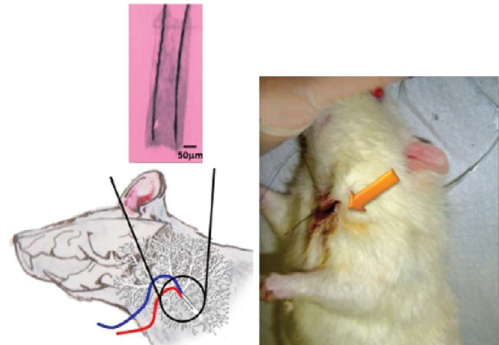
Fig. 15. An optical microscope image of the flexible carbon fiber-based biofuel cell inside the catheter which was surgi- cally implanted in the jugular vein of a rat [123,129].